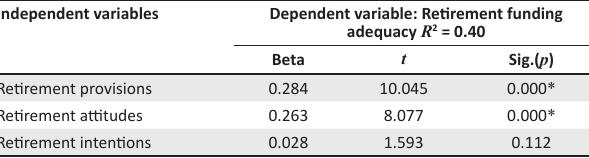
TABLE 4: Influence of the independent variables on retirement funding adequacy. Independent variables Dependent variable: Retirement funding adequacy R 2 =